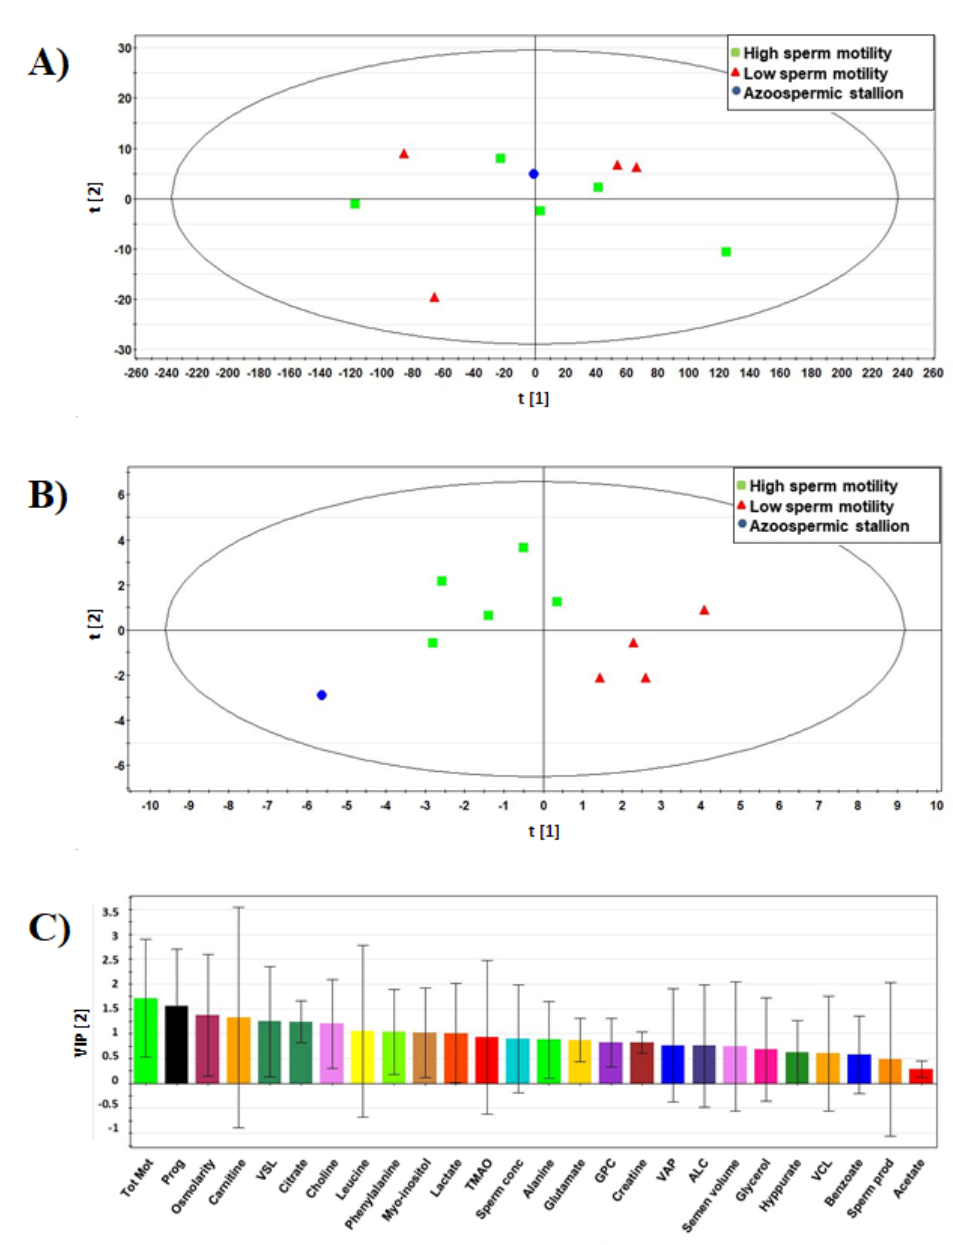
Figure 2. Multivariate analyses of seminal plasma metabolites, semen parameters and sperm kinetics in donkey stallions ( n = 10). ( A ) PCA score scatter plot from both the 1 H-NMR spectral data and data of sperm quality. PCA resulted in a two-component model with an R 2 X value of 0.992 and a Q 2 of 0.287. ( B ) PLS-DA score plot obtained from the same dataset. The values of this two-component model were R 2 X = 0.49; R 2 Y = 0.737; Q 2 = 0.265. In both score plots, green boxes represent stallions with high sperm motility ( n = 5); red triangles represent stallions with lower sperm motility ( n = 4); a dot represents the azoospermic stallion ( n = 1). ( C ) Variable importance in projection (VIP) of the variables for model reported in B. Tot Mot (total sperm motility), Prog (progressive sperm motility), VCL (curvilinear velocity), VSL (straight-line velocity), VAP (average path velocity), Sperm prod (sperm production), GPC (glycerophosphocholine), ALC (O-acetyl carnitine), TMAO (trimethylamine N ‐ oxide).